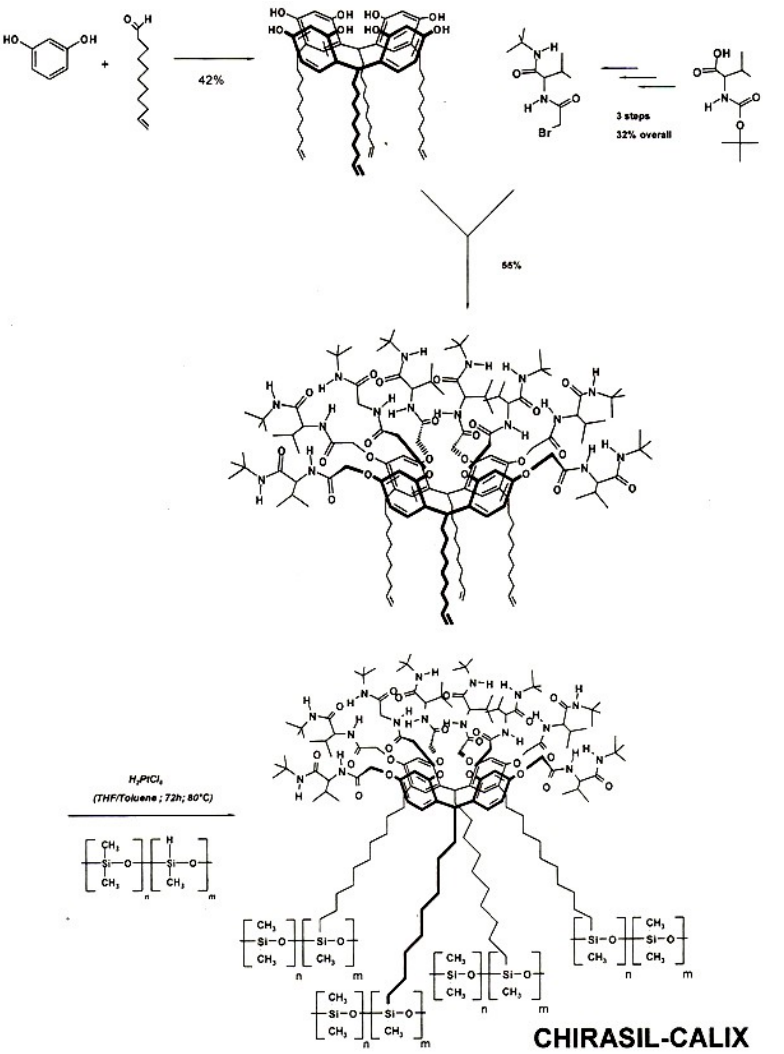
Figure 31. Synthesis of the CSP Chirasil-Calix. Reprinted with permission from [123].